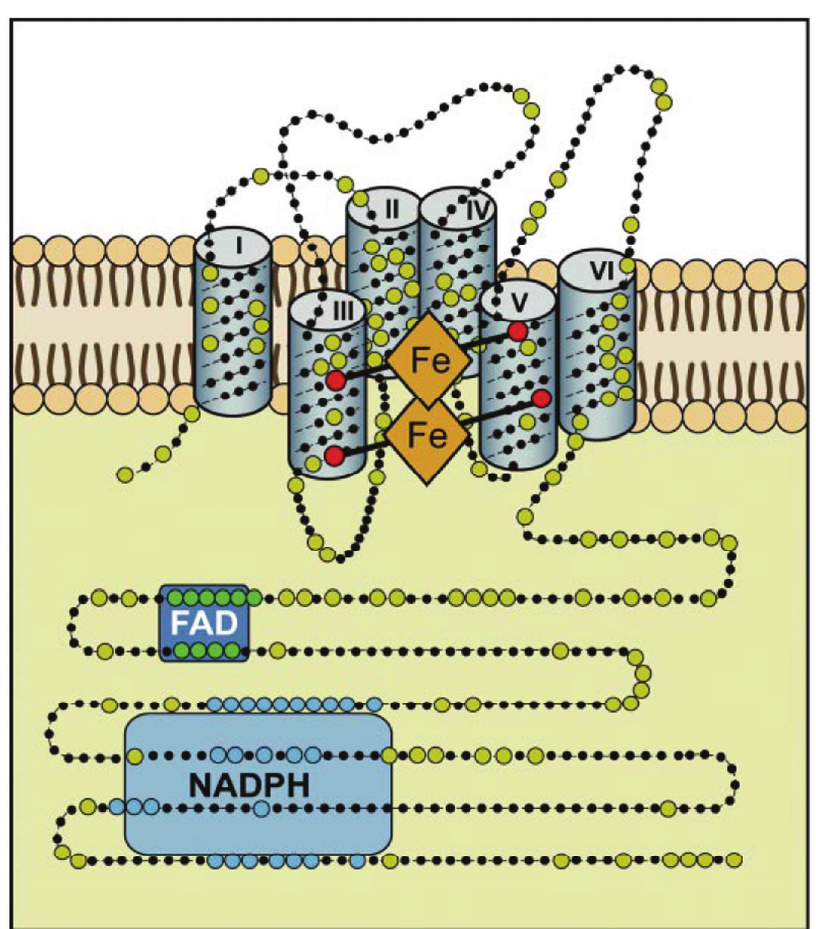
Figure 3. Hypothetical structure of a typical NADPH oxidase. This structural model is based on bioinformatics, cell fractionation and biochemical data concerning the human Nox enyzmes (NOX1, 2, 3, and 4); no crystallographic or NMR structural data are available yet. Nox enzymes comprise typically about 500 amino acids and are exclusively located in lipid bylayer membranes, like the plasma membrane or the ER membrane. Large dots are highly conserved amino acids. The reaction center transferring a single electron to oxygen is the upper b-type heme in this scheme. The enzyme consists of six transmembrane helices. The two b-type hemes are coordinated with histidine residues between helices III and V. The enzyme contains binding sequences for NADPH as well as for FAD in its cytoplasmic tail (after Bedard and Krause 2007